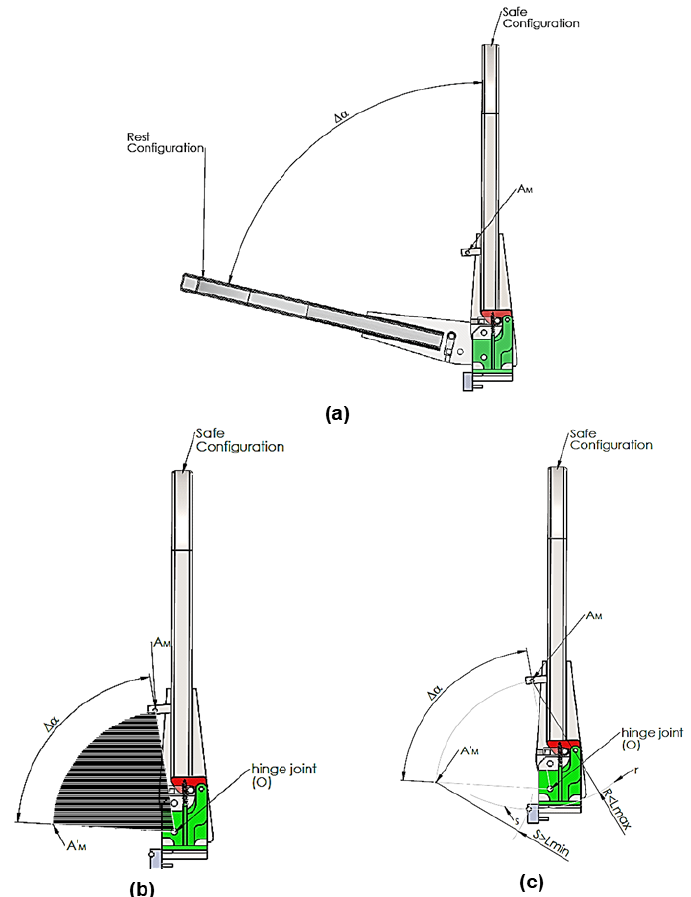
Figure 6. Procedure to define the A F and A M points: ( a ) determination of the angular range of motion ∆ α and A M ; ( b ) determination of the A M point in the rest configuration (A’ M ); ( c ) determination of the fixed anchorage point of the linear actuator (A F ).